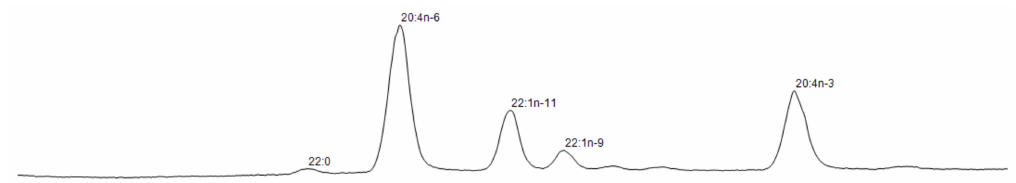
Figure 1. Chromatogram showing the separation of cetoleic acid (22:1n-11) and erucic acid (22:1n-9) in the fatty acid analysis.